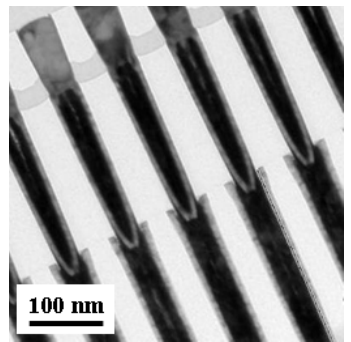
Figure 8. TEM image of plug performance in advanced small via application based on CVD TiCl 4 -based TiN.